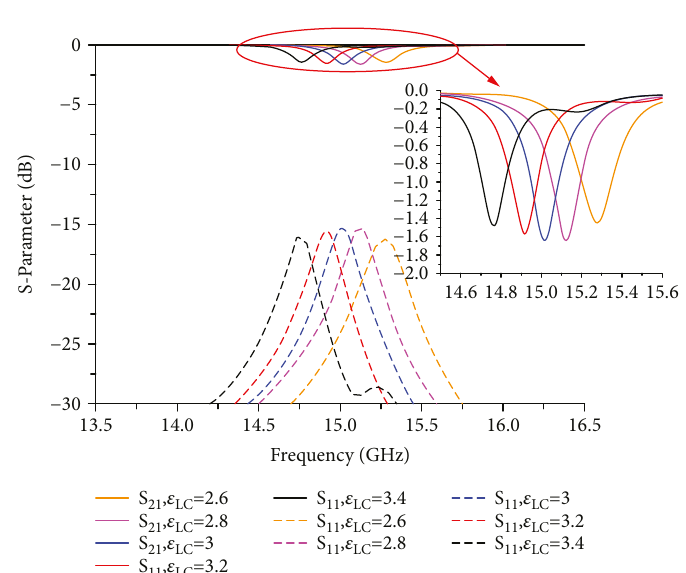
Figure 3: Simulated S-parameters of the antenna element with di ff erent ε